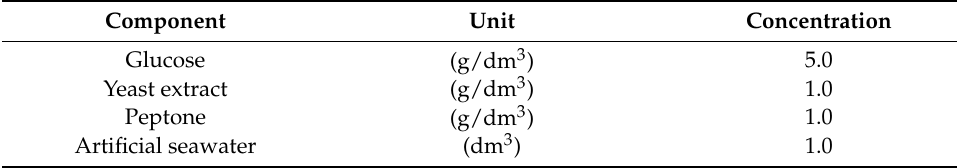
Table 1. Composition of the ATCC790 By+ culture medium.